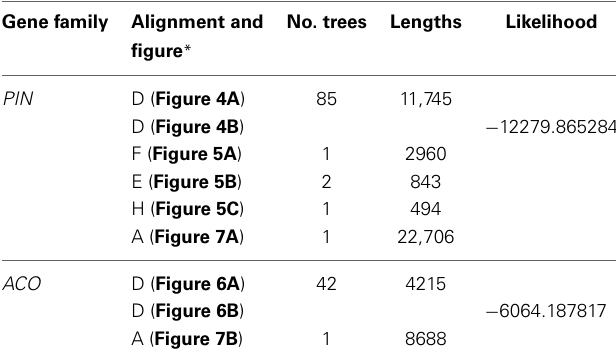
Table 3 | The number of most parsimonious trees found and their lengths, or the log likelihoods, for each of the alignments searched. Gene family Alignment and No. trees